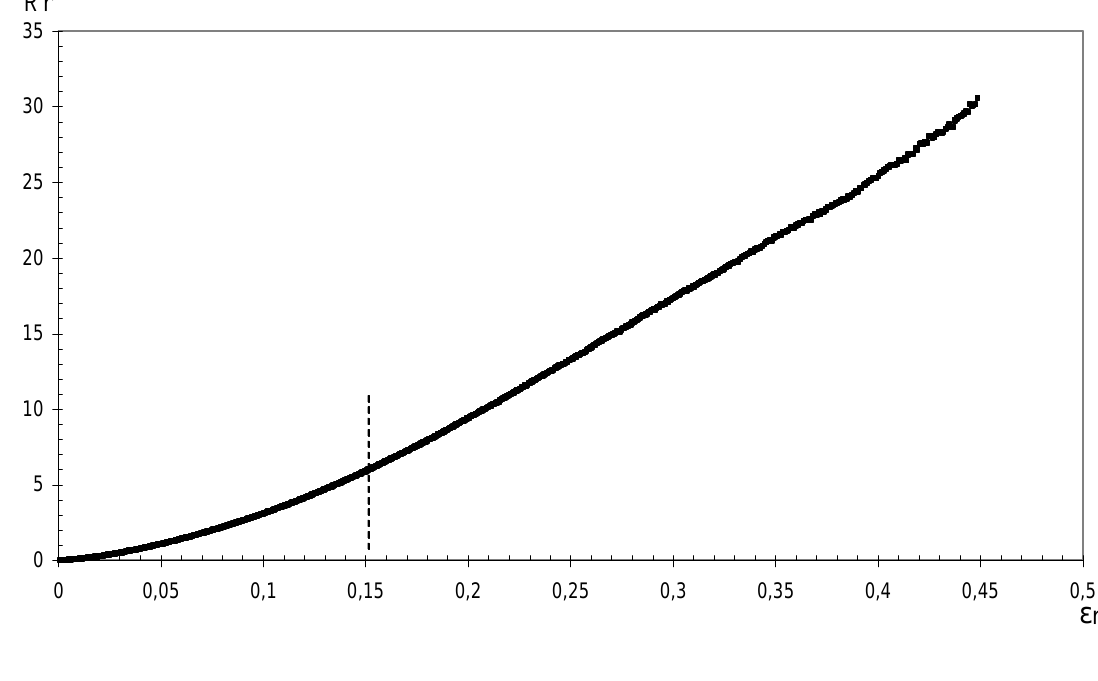
Figure 7. Electrical resistivity vs. strain of the